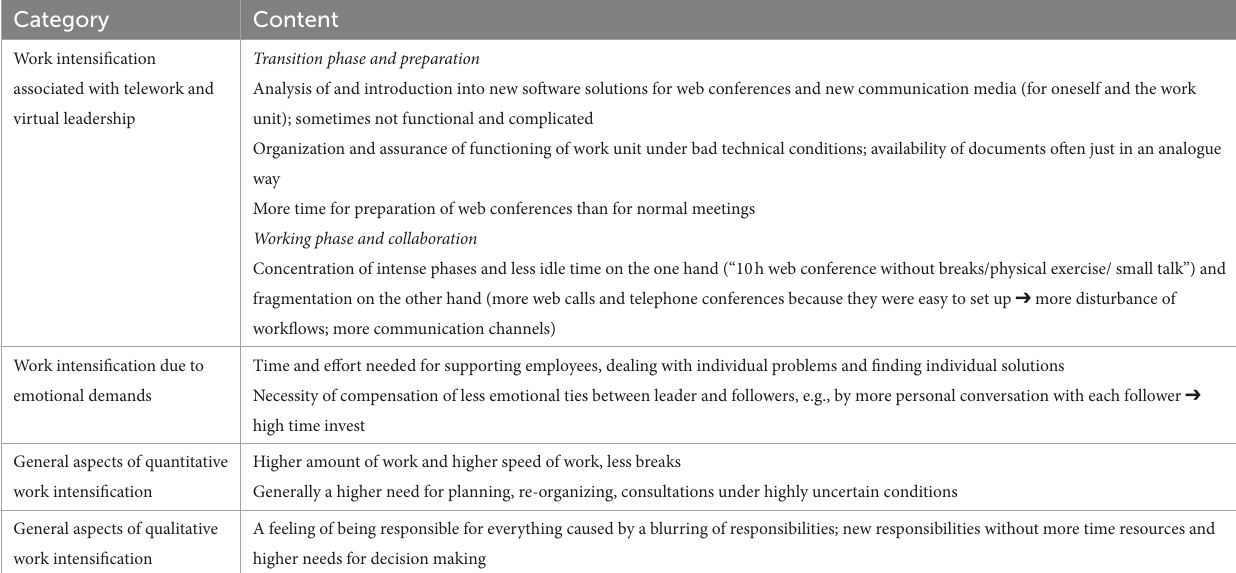
TABLE 5 Summary of the results from the qualitative follow-up: work